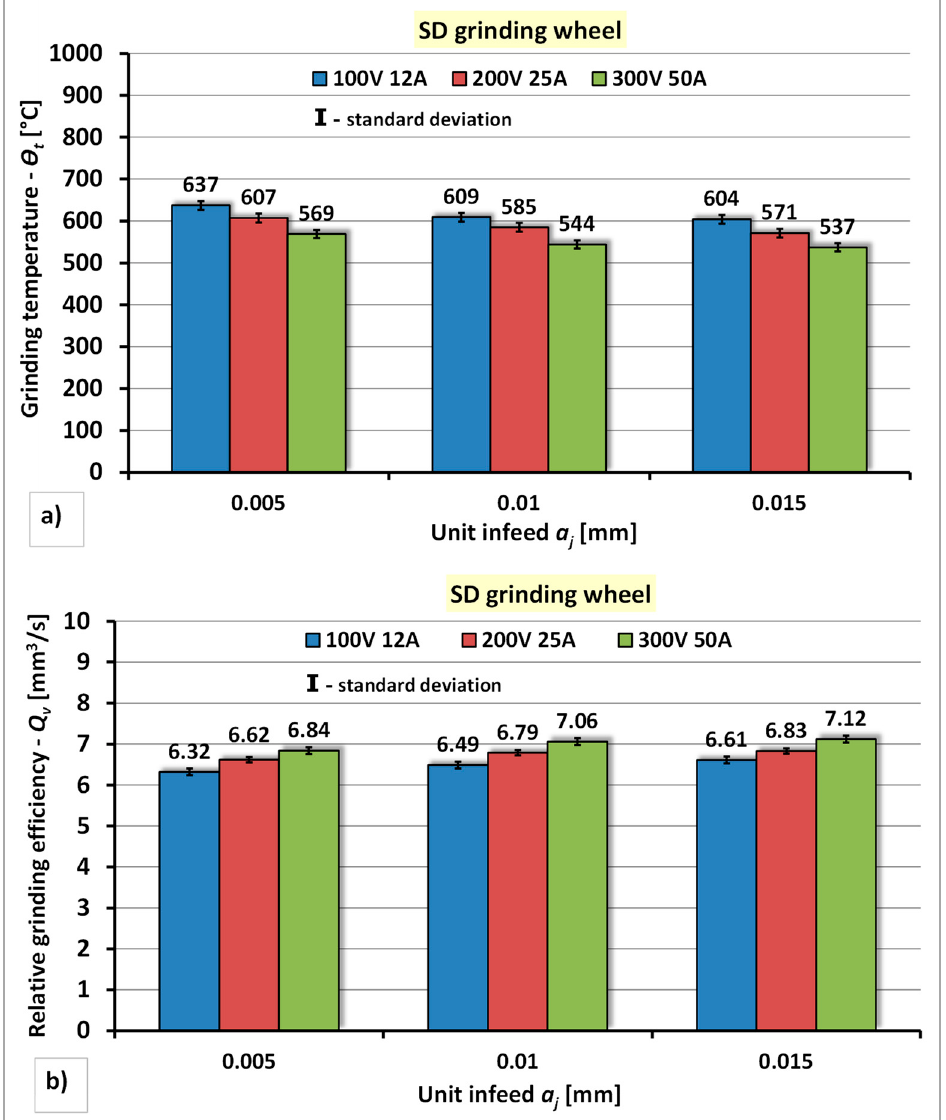
Figure 7. The effect of the generator power and unit infeed during electrodischarge dressing of a diamond grinding wheel using a stationary electrode: ( a ) On the grinding temperature— Θ t ; ( b ) On the relative grinding efficiency— Q v .